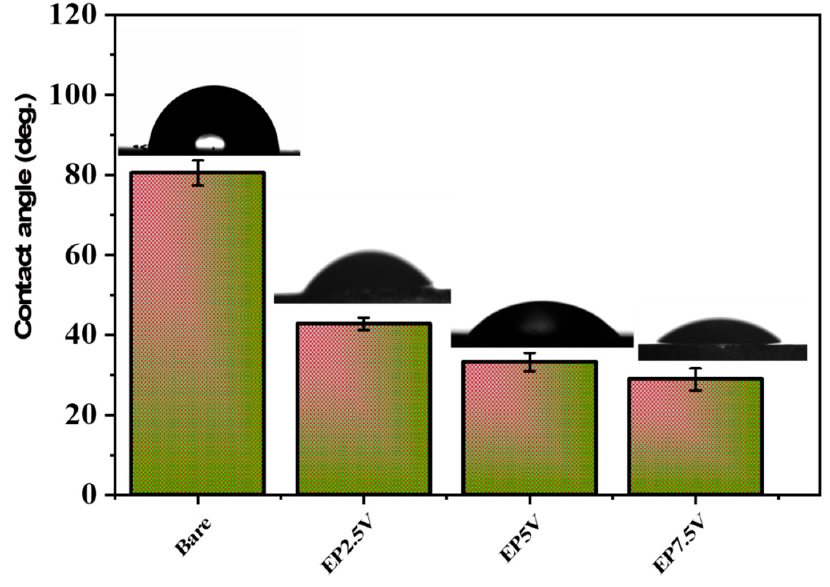
Figure 3. WCA results of untreated and treated 316L SS specimens.